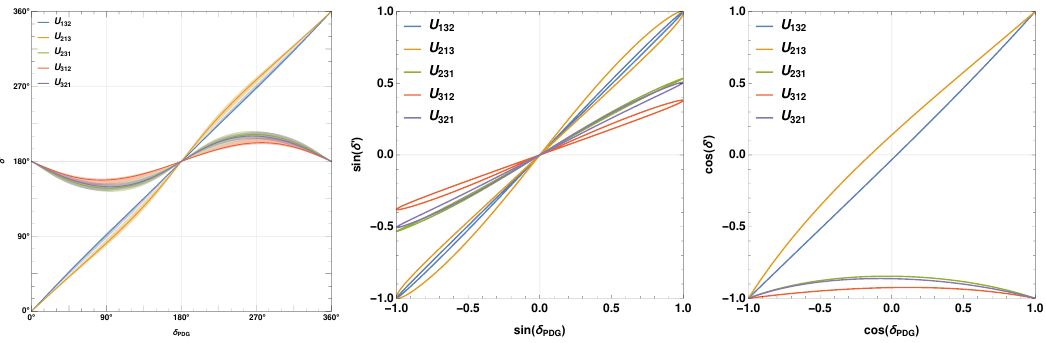
Figure 1 . Comparison of the CP-violating phase of U PDG ( δ PDG ) and that of other parameteri- zations of the neutrino mixing matrix ( δ 0 ). The shaded regions on the left plot show the range of variations of the curves over the 3 σ range of mixing angles from